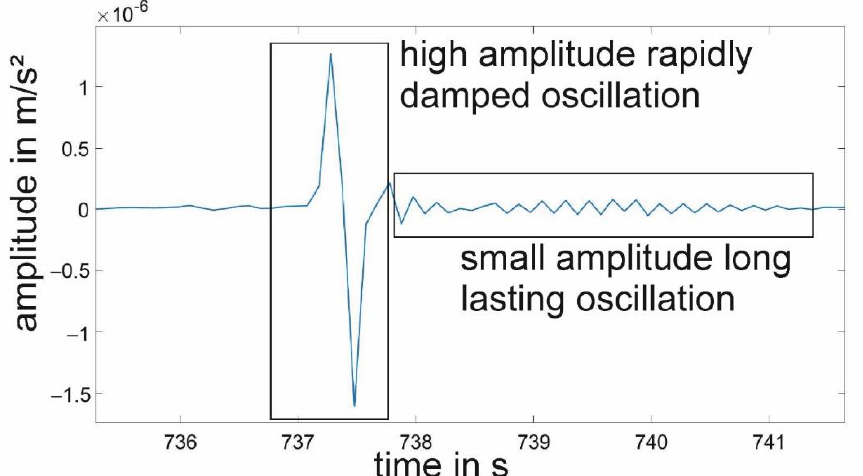
Figure 2. A twang in the accelerometer measurements consisting of two parts. The first part is a high amplitude oscillation, which is followed by an oscillation with smaller amplitude that decays more slowly.